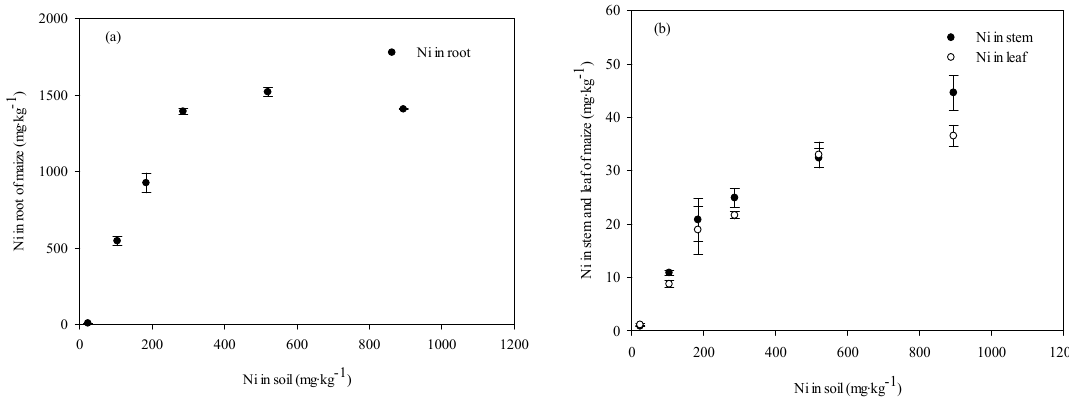
Figure 4. Tissue Ni concentrations (Mean ± SE, n = 5) in the ( a ) roots and ( b ) stems and leaves of maize seedlings after exposure to NiCl 2 added to the soil. Maize seedlings were sampled 28 days after emergence.